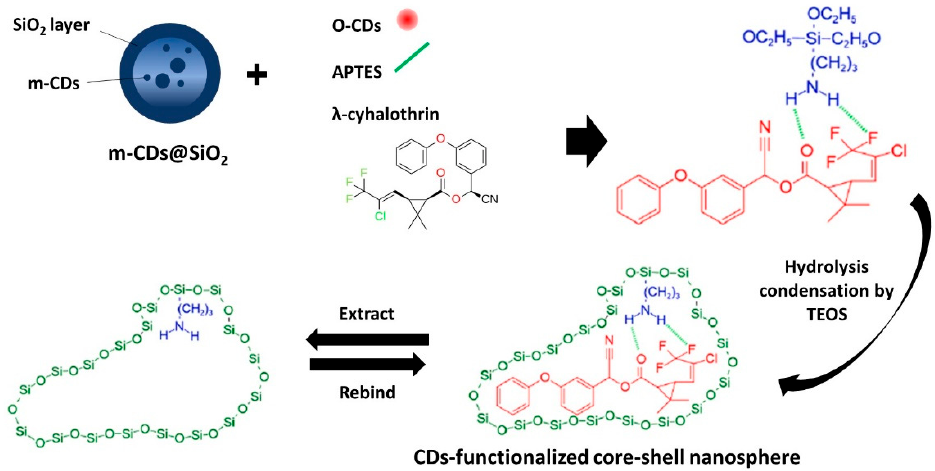
Figure 8. Schematic diagram of binding reactions of the prepared CD-functionalized core-shell nanospheres for detection of λ -cyhalothrin. Table 12. Summary of the developed optical sensors for pesticides detection.